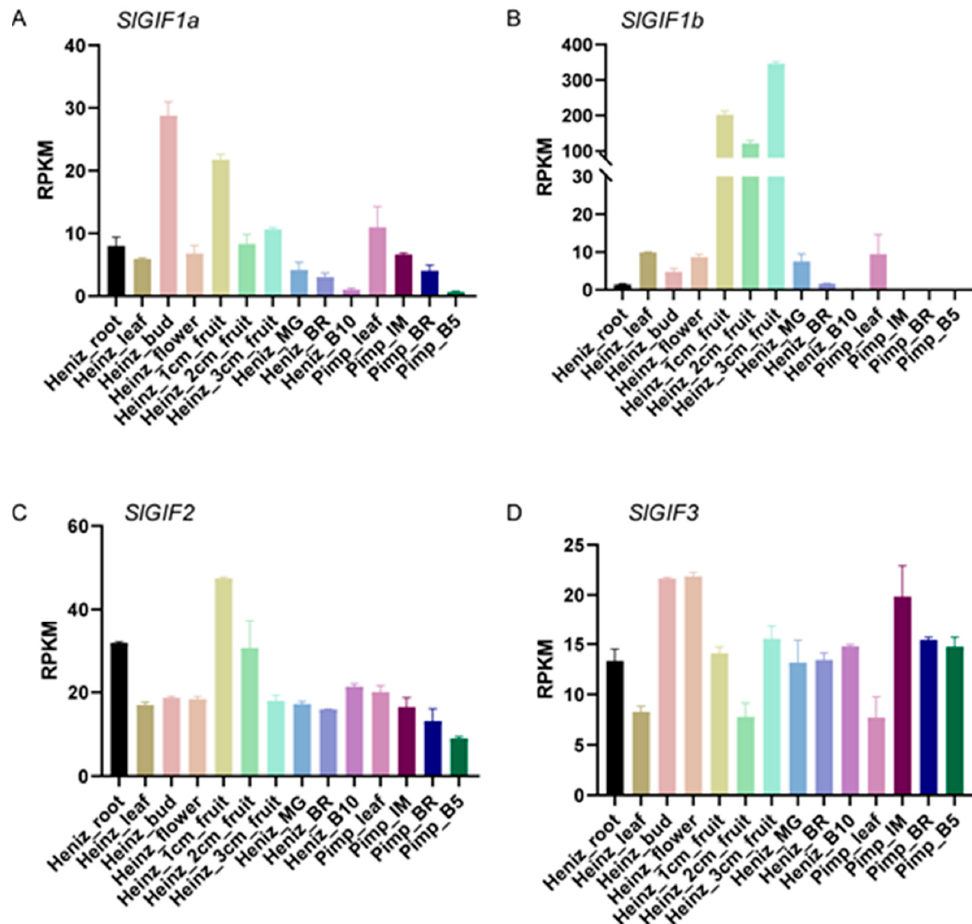
Figure 4. Expression profiles of the SlGIF genes ( SlGIF1 ( A ), SlGIF2 ( B ), SlGIF3 ( C ), and SlGIF4 ( D )) in different tissues from Heinz 1706 and LA1589. Normalized expressions (RPKM) of each genes in different tissues, containing root, leaf, bud, flower, 1 cm fruit, 2 cm fruit, 3 cm fruit, mature green (MG), breaker (BR, early ripening), and 10 days post breaker (B10, red ripe) from Heinz 1706 and leaf, immature fruit (IM), breaker (BR), and red (B5) from Solanum pimpinellifolium (S. pimpinellifolium ) (Pimp) LA1589 [32] stand for the expression of SlGIF genes in different tissues. RPKM are displayed as means ± SD ( n = 2).